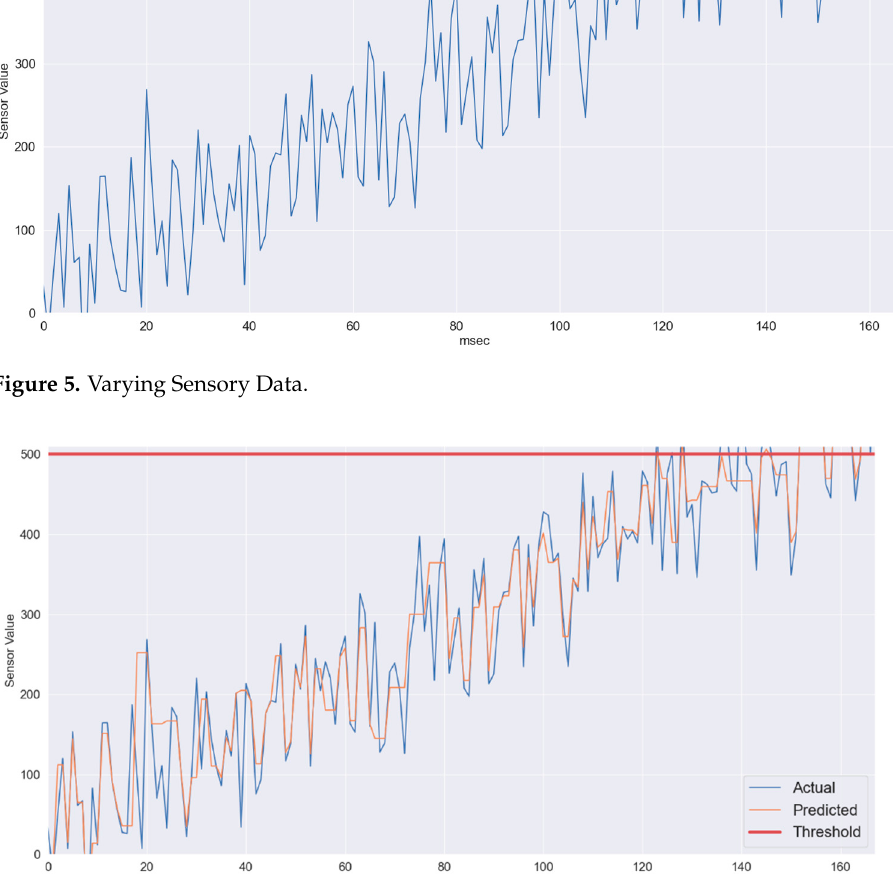
Figure 7. Rapidly changing sensory data.